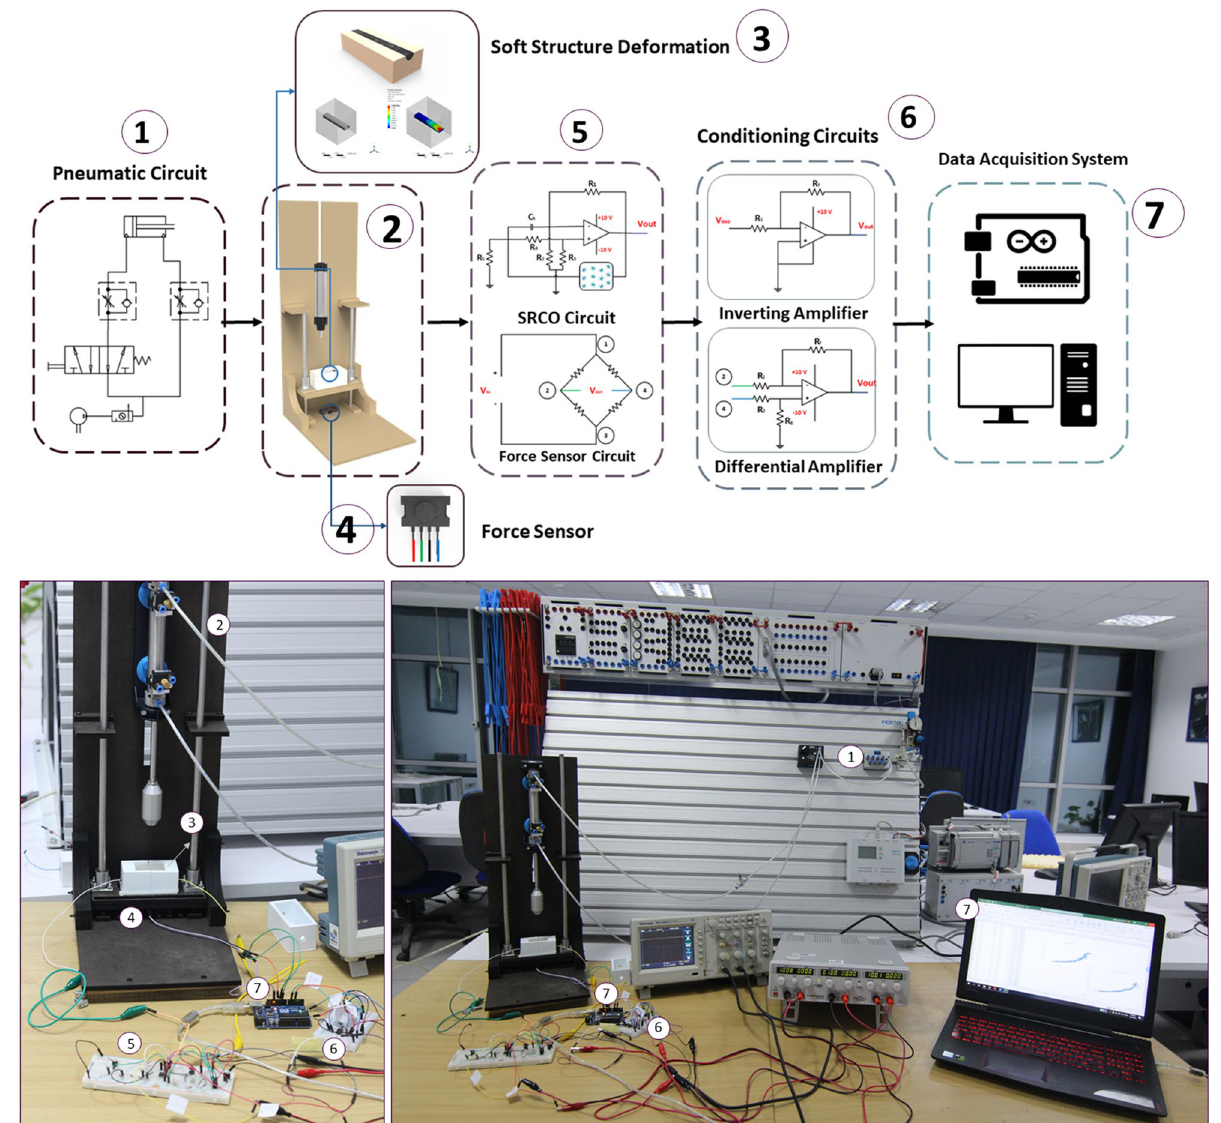
(2) where the silicone structure (3) is placed. The two variables; force acquired by the force sensor (4) and change in bioimpedance acquired in the form of change of output frequency of SRCO circuit (5), undergo two signal conditioning circuits (6) before being acquired by the data acquisition circuit